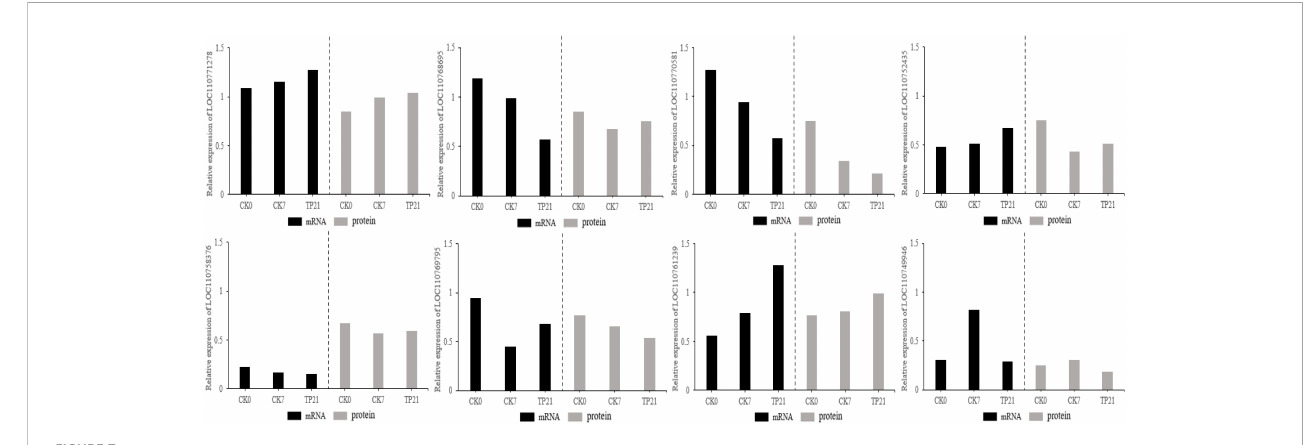
FIGURE 7 Veri fi cation of genes of protein using